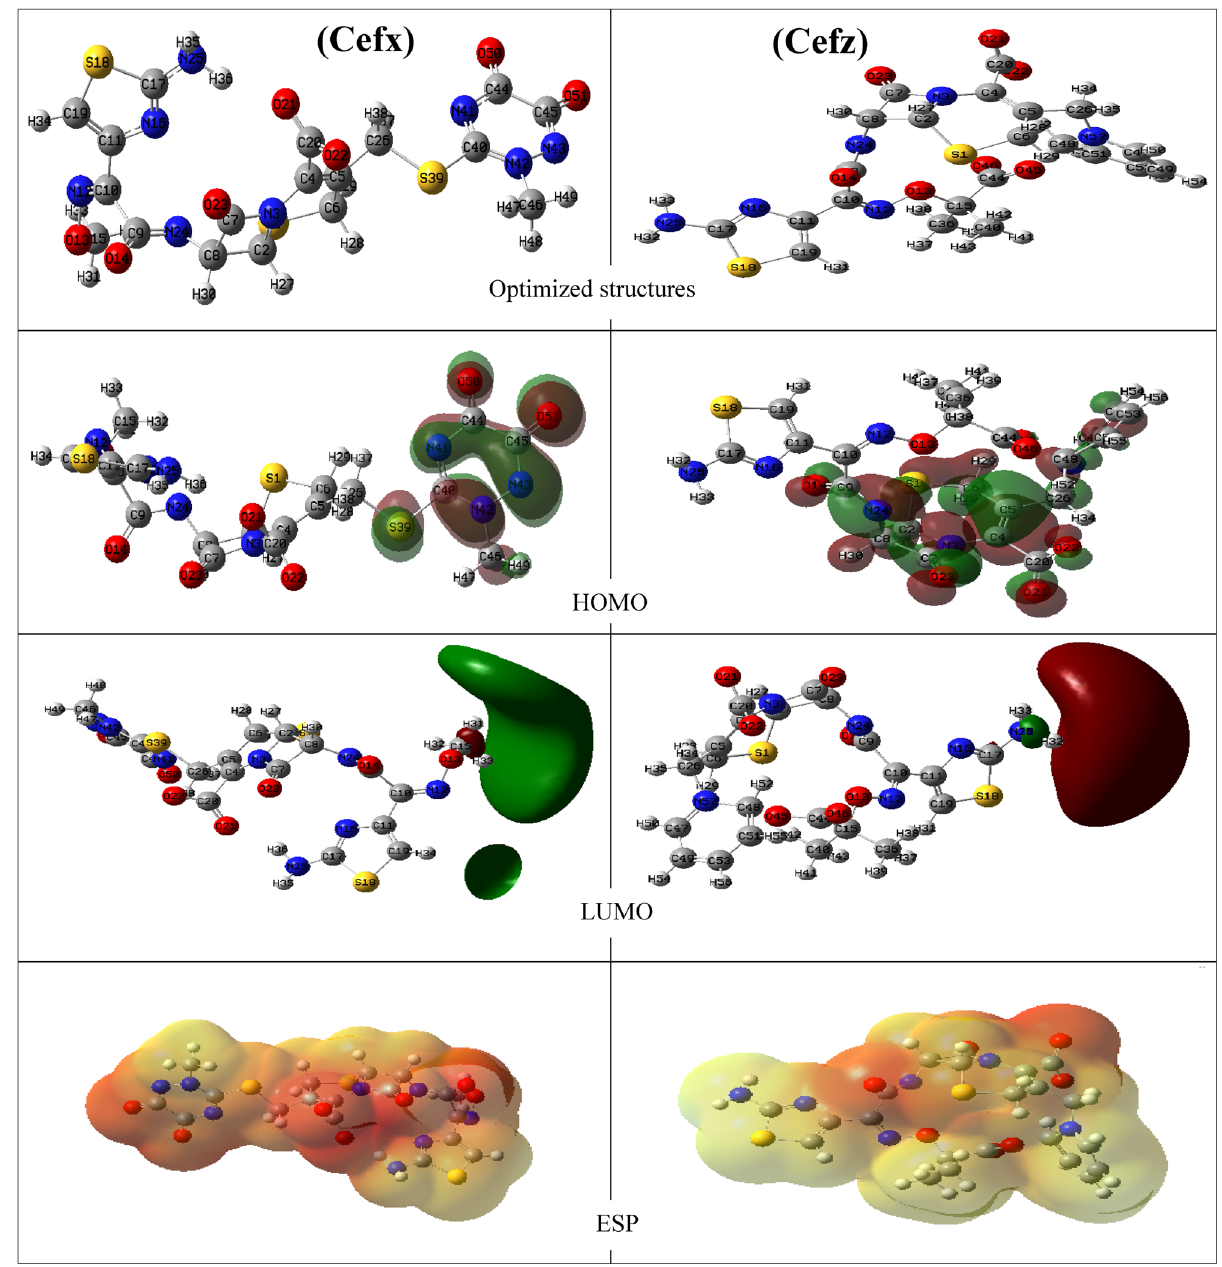
Figure 14. The optimized structures, HOMOs, LUMOs and electrostatic potential (ESP) structures of Cefx and Cefz drugs using HF /6–311++G (d, p)